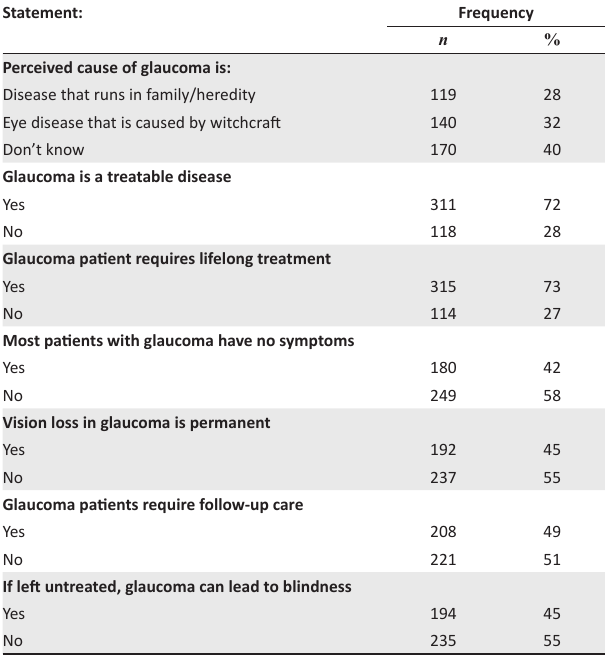
TABLE1: Respondents’ level of glaucoma knowledge ( n =